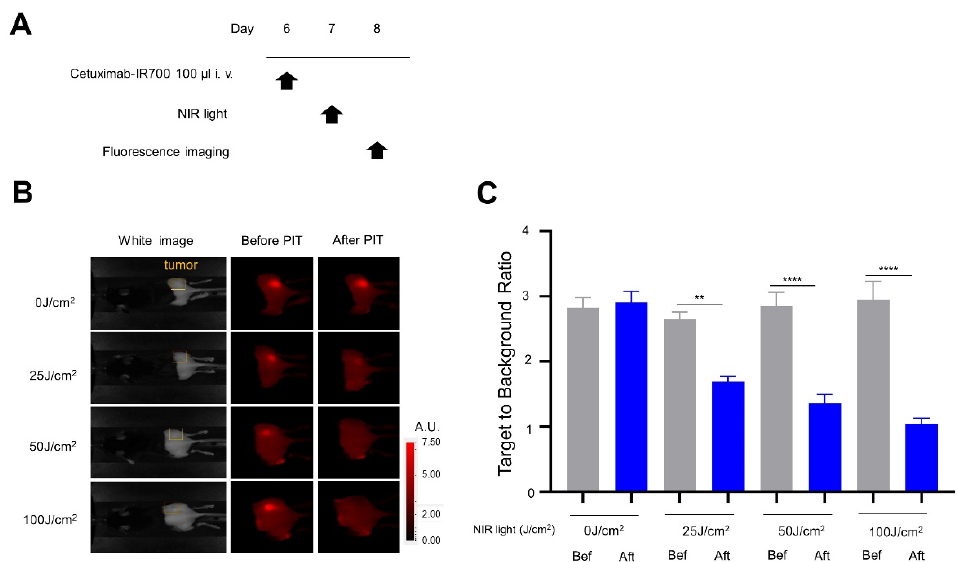
Figure 5. In vivo short-term efficacy of NIR-PIT with Cet-IR700 in mEERL-hEGFR tumors: ( A ) treatment schedule; ( B ) IR700 fluorescence images for IR700 fluorescence were obtained in each NIR light dose before and after NIR-PIT. The yellow areas represent the location of the tumor (A.U., arbitrary unit); ( C ) target-to-background ratio of IR700 fluorescence. ( n = 10; one-way ANOVA followed by Tukey’s test; **, p < 0.01 and ****, p < 0.0001; Bef: before; Aft: after).